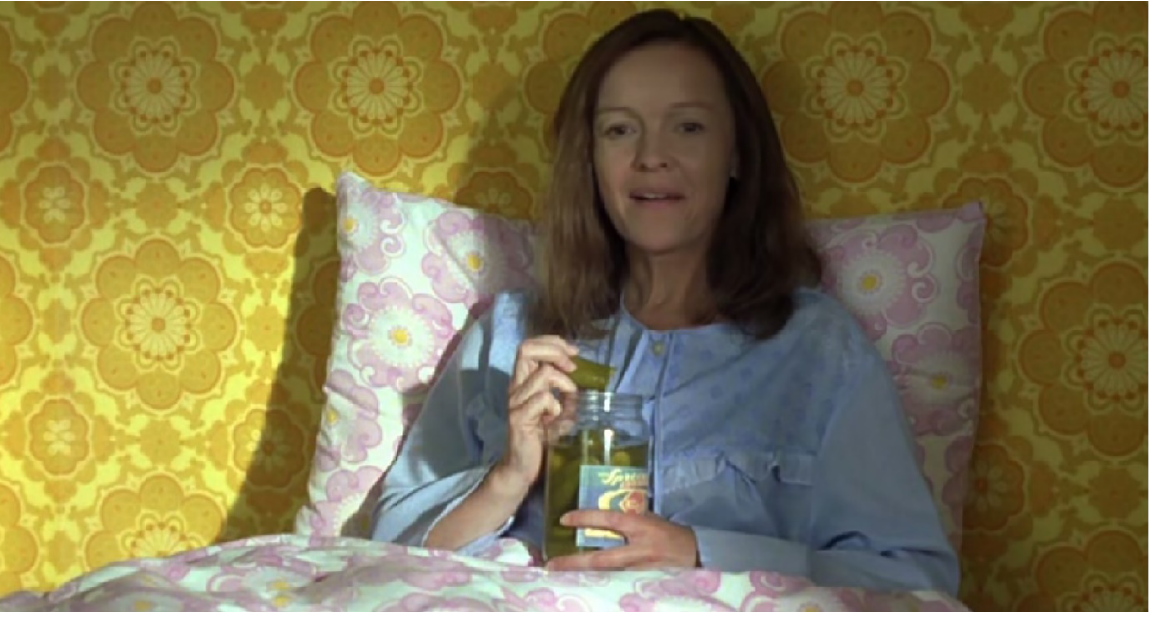
Figure 3 Mother supposes that she eats Spreewald pickles.